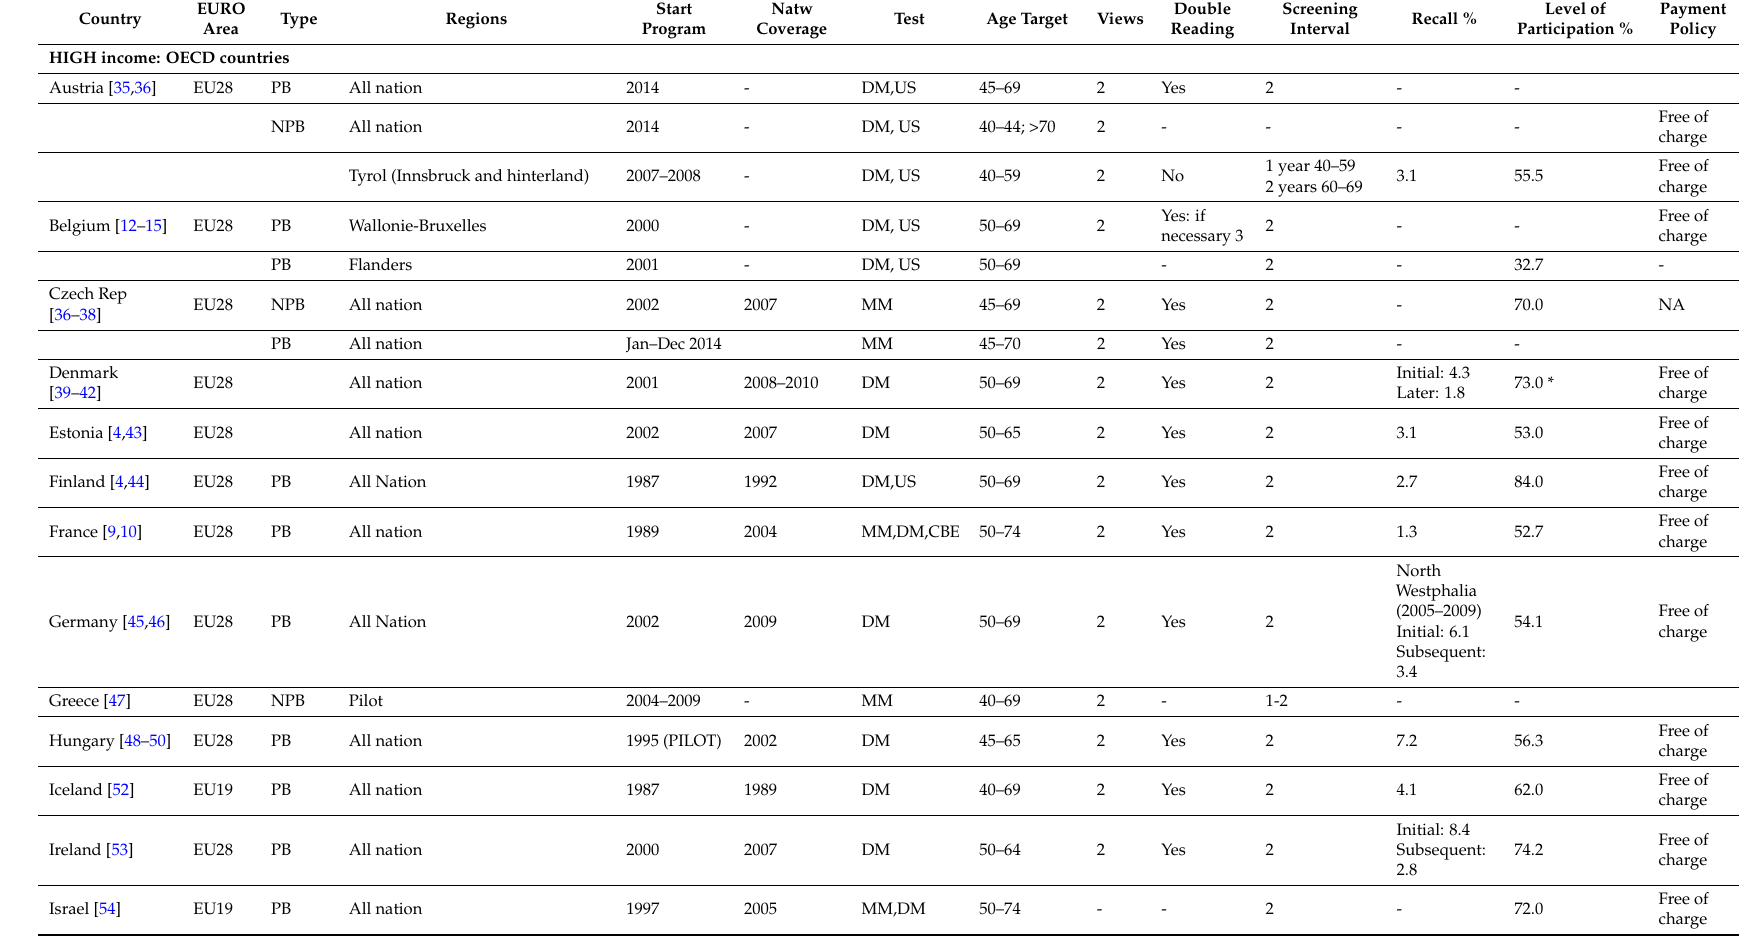
Table 3. Distribution of Breast Cancer screening programmes in 53 WHO European Countries as of July